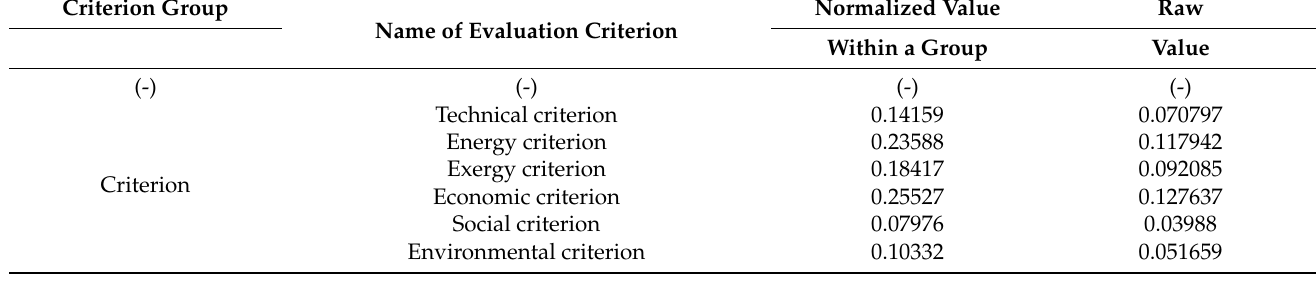
Table 3. Weight vectors for the main evaluation criteria, all decisionmakers.